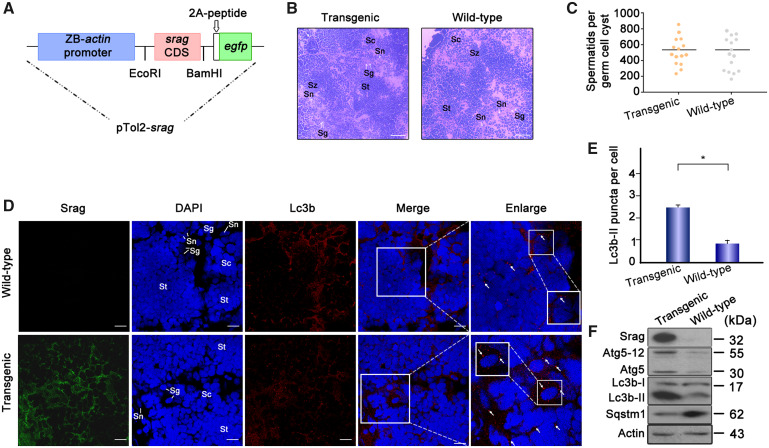

srag transgenic zebrafish analysis. (A) Schematic depiction of the pTol2-srag-egfp transgenic construct. The transgenic structure contains a region of the zebrafish actin promoter linked with the srag CDS (coding DNA sequence), a gfp tag, and 2A peptide cloned into the pTol2 vector. (B) Histological analysis of adult testis samples of srag transgenic and wild-type zebrafish by H&E staining. The white arrows indicate spermatogonia (sg) and Sertoli cells (sn). Scale bar: 50 μm. (C) Spermatid number in germ cell cyst in testis between srag transgenic and wild-type zebrafish (P < 0.9). (D) Immunofluorescence analysis of testis samples in both transgenic and wild-type zebrafish using anti-LC3B antibody. Images were captured using confocal microscopy. Lc3b-II puncta were obviously increased in the srag transgenic testis in comparison with wild type in spermatids (St), spermatocytes (Sc), and spermatogonia (Sg). The nuclei were stained by DAPI (blue). The enlarged images on the right panels originated from the white squares, the white arrows indicate Lc3-II puncta in spermatocytes (Sc). Enlarged box within the image highlights Lc3b-II puncta in Sertoli cells (Sn). Scale bar: 10 μm. (E) The number of Lc3b-II puncta was quantified from ∼20 cells for each group from (D). Data were presented as means ± SD. T-test was performed, *P < 0.05; **P < 0.01 (n = 3 independent experiments). (F) Western blot analysis of testis samples in both srag transgenic and wild-type zebrafish. Srag protein was detected in transgenic testis but not in wild type using the anti-Srag antibody. β-Actin was used as a control. Western blot analysis indicated that Lc3b-II and Atg5-Atg12 were upregulated, whereas Sqstm1 was downregulated in testis of transgenic zebrafish.